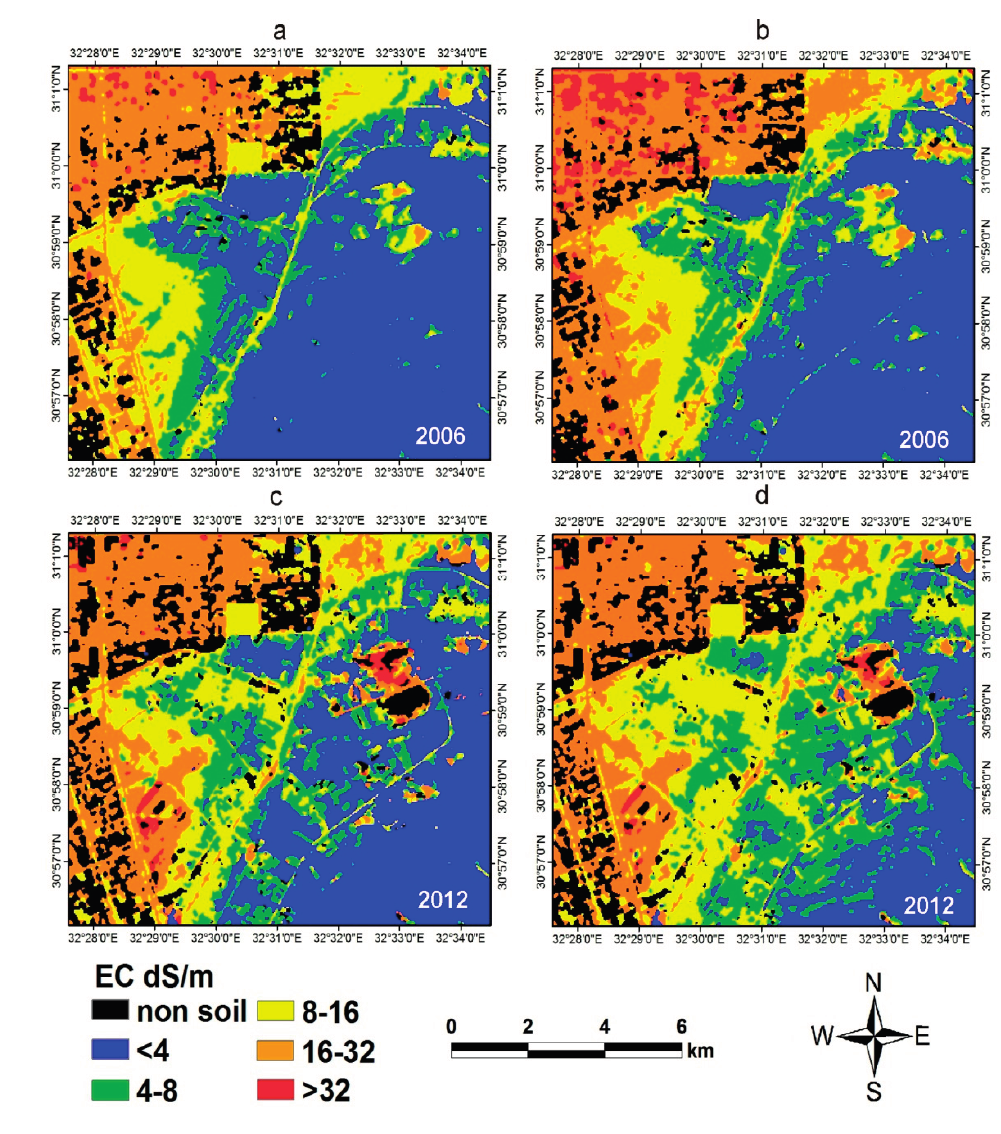
Figure 7. ( a ) PLSR results for 2006; ( b ) MARS results for 2006; ( c ) PLSR results for 2012; and ( d ) MARS results for